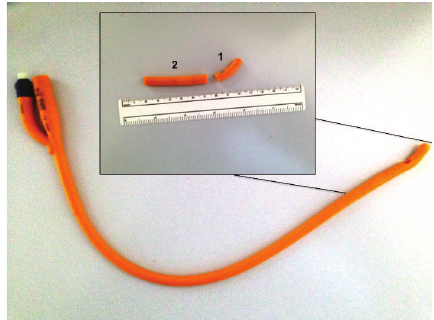
Figure 1: The urinary catheter preparation procedure for the